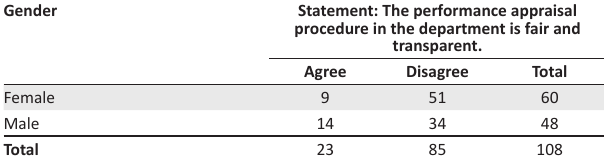
TABLE 4: Cross-tabulation of employee opinions about performance appraisals by gender.